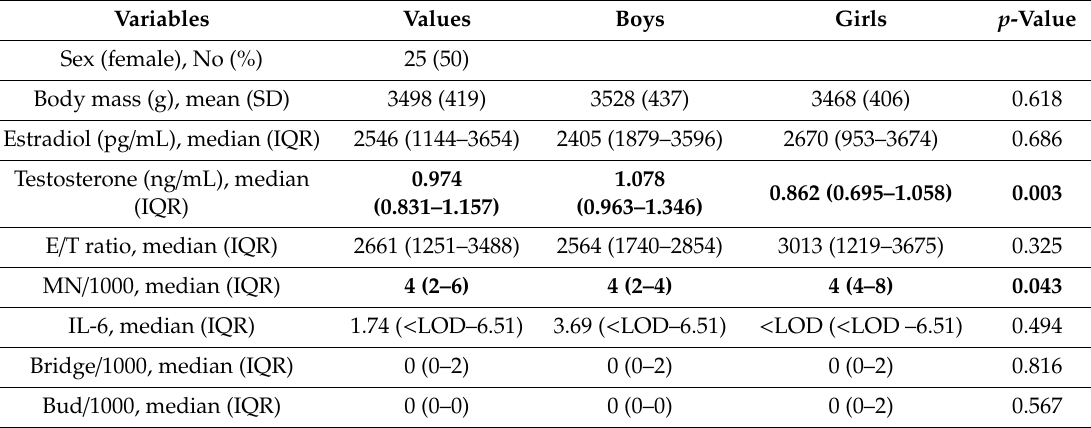
Table 1. Newborns’ sex, weight, testosterone, estradiol, and IL-6 levels and markers of genome damage ( N = 50).